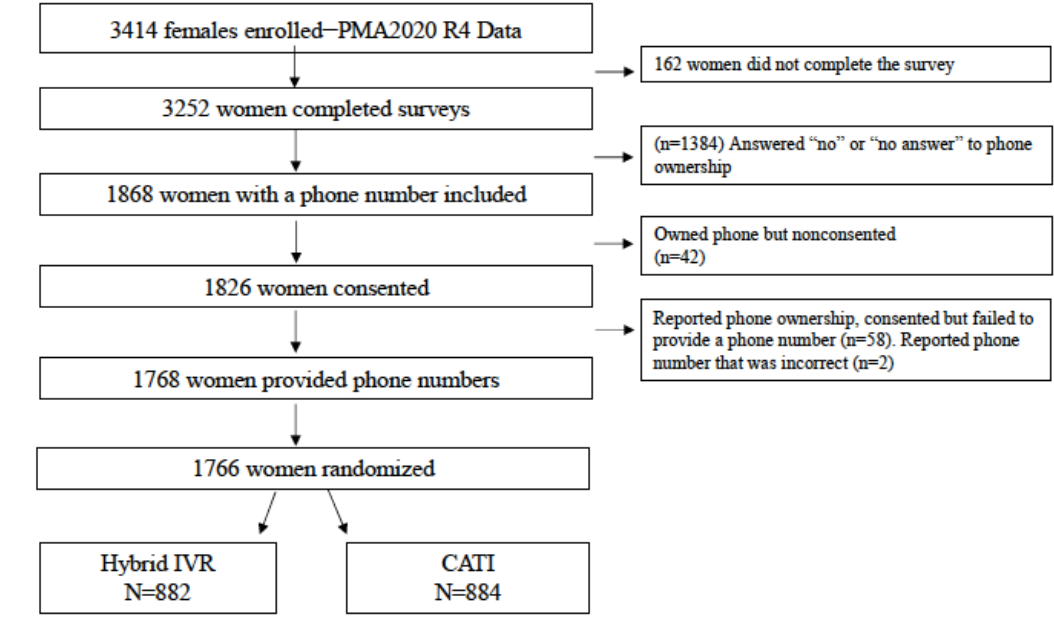
Figure 1. Study enrollment flow